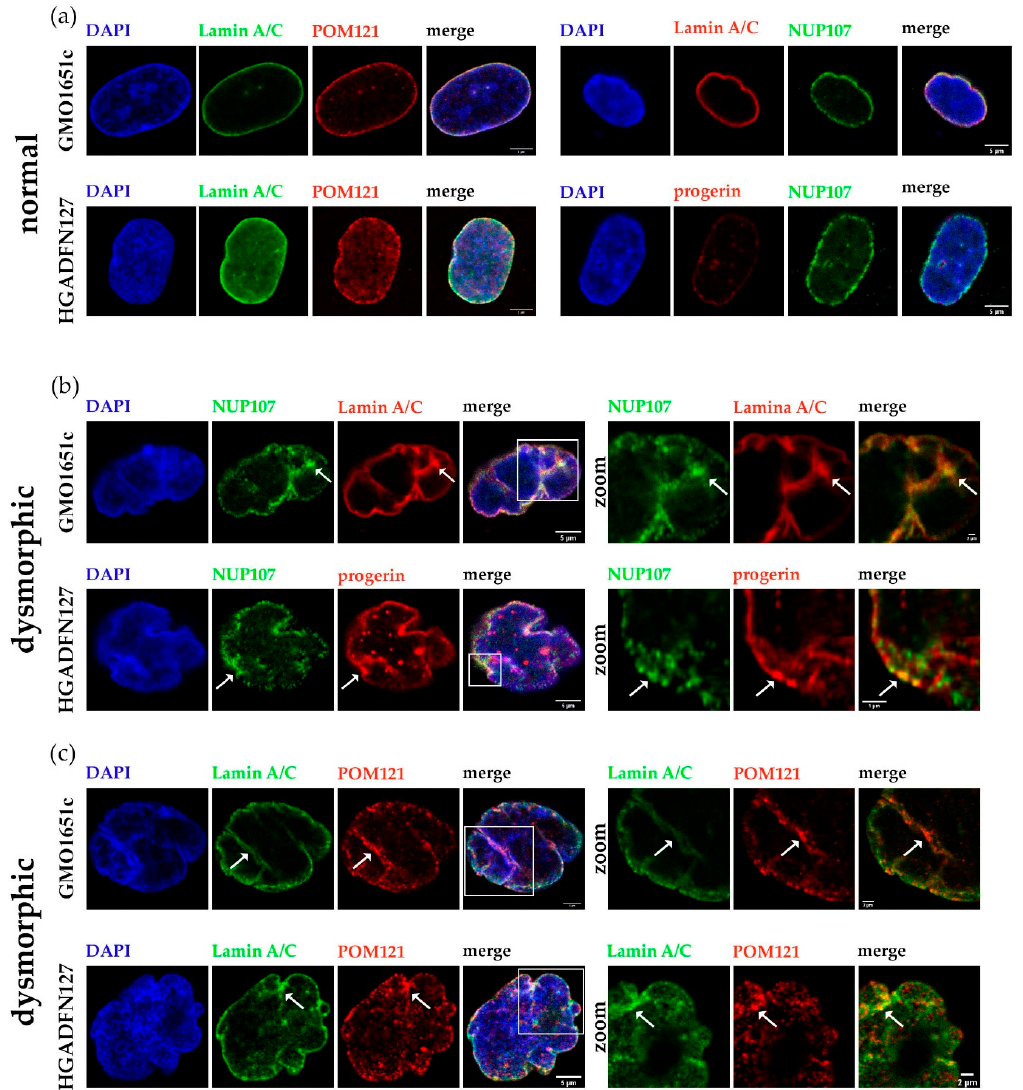
Figure 9. NPCs clustered in folds of dysmorphic nuclear envelopes and co-localized with progerin/Lamin A aggregates trapped at the nuclear membrane. ( a ) Representative images of normal control (GMO1651c) and HGPS (HGADFN127) nuclei stained with α -NUP107/POM121/LA/progerin antibodies, counterstained with DAPI. ( b ) Representative images of dysmorphic control and HGPS nuclei, stained with α -NUP107 and α -LA/C or progerin antibodies, counterstained with DAPI. ( c ) Representative images of dysmorphic control and HGPS nuclei, stained with α -POM121 and LA antibodies, counterstained with DAPI. Arrows indicate regions with clustered NPCs, outlines indicate zoomed in section of nuclei. All images are taken from z-stack and are provided as X-Z view. Zoom factor: ( b ) GMO1651c 15x, HGADFN127 25x; ( c ) GMO1651c 9x, HGADFN127 12x.